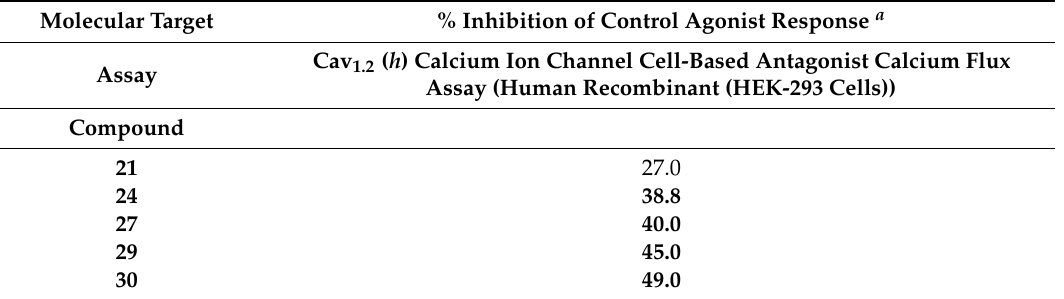
Table 3. In vitro functional assays for several compounds at concentration of 10 µ